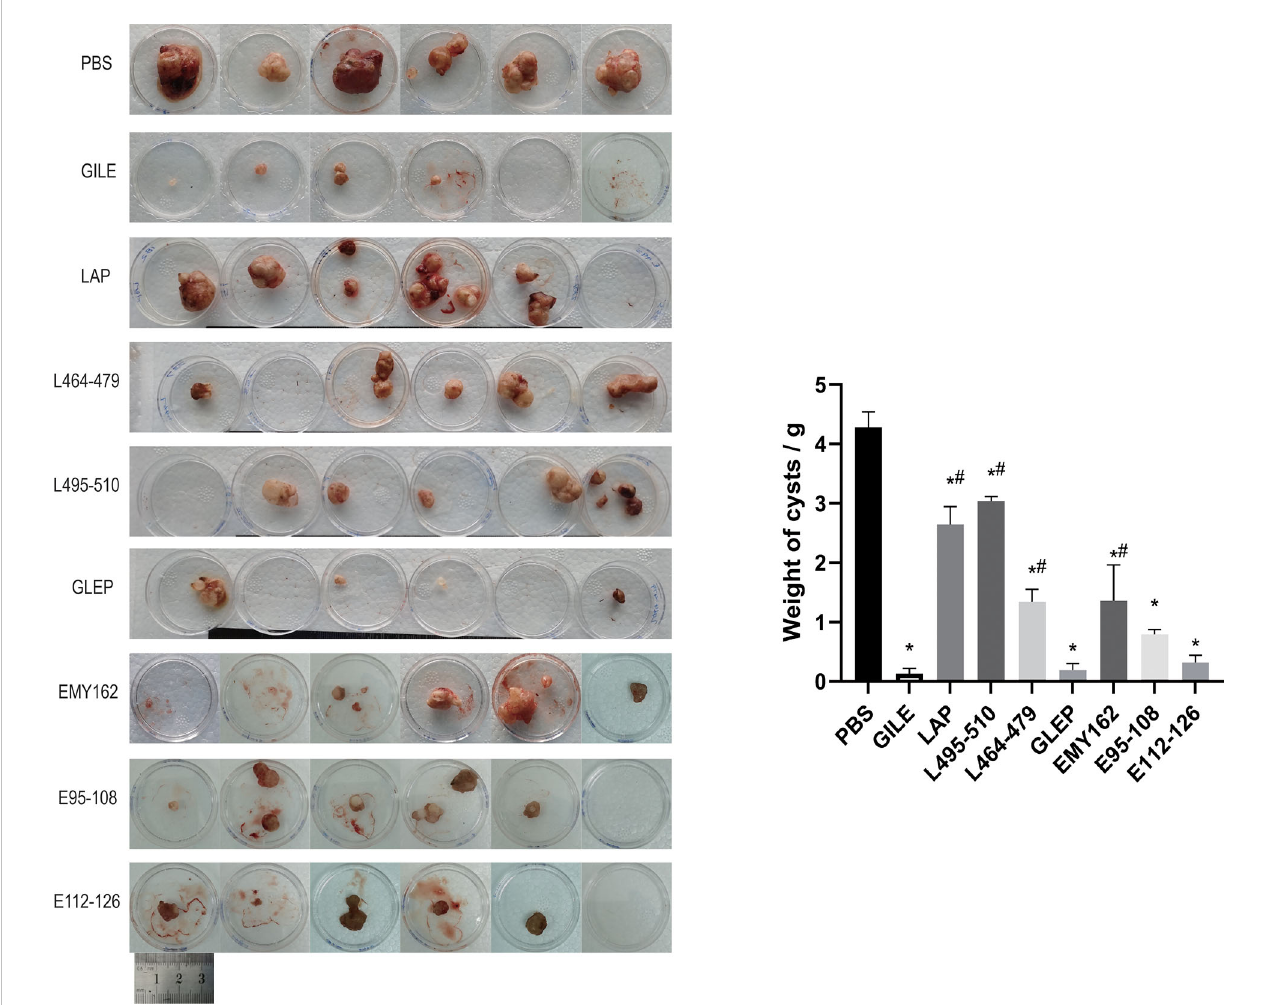
FIGURE 7 Detection of every challenge experiment mouse the size and number of cysts in enterocoelia and liver after prophylaxis (*: P<0.05 vs PBS, #: P<0.05 vs GILE).